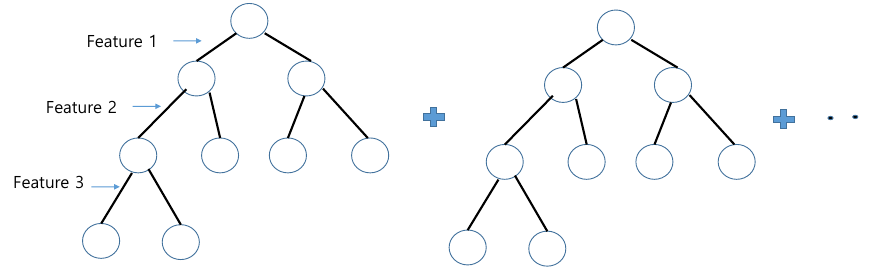
Figure 2. A schematic diagram of a boosted regression